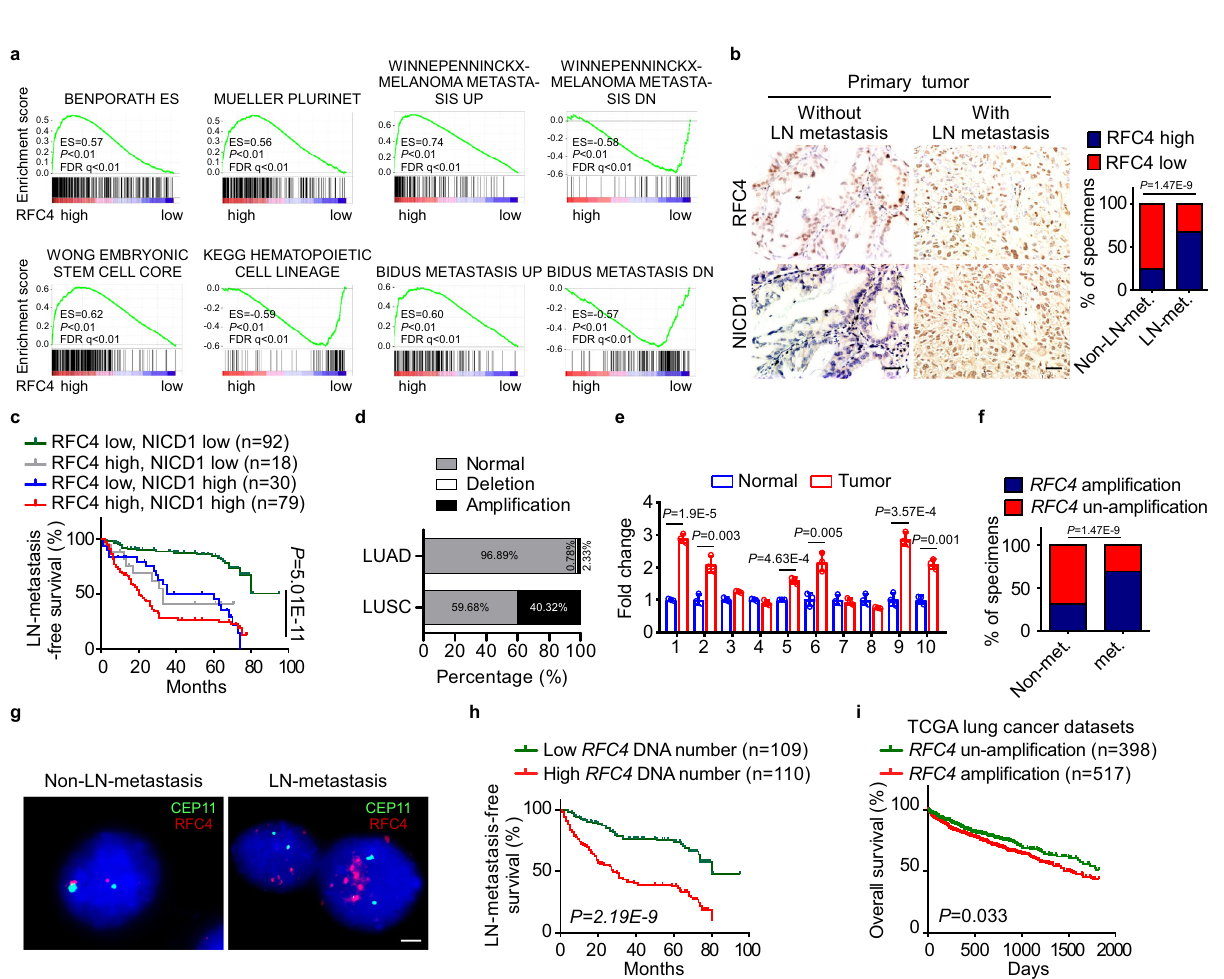
Fig. 7 RFC4 is ampli fi ed in NSCLC and correlates with NSCLC progression. a GSEA analysis of the TCGA lung cancer datasets by Kolmogorov – Smirnov test shows correlation between RFC4 and tumor metastasis- and stemness-associated signatures. b Images of IHC staining for RFC4 and NICD1 in the same set of consecutive tissue slices of primary tumors from 219 NSCLC patients with or without LN metastasis, and the percentages of specimens expressing low or high RFC4 from these NSCLC patients. Two representative cases are shown. Scale bar: 100 μ m. c Kaplan – Meier analysis of the LN metastasis-free survival of our cohort of 219 NSCLC patients by log-rank test, who were divided into low- or high RFC4 and low- or high-NICD1 expression subgroups. The medians of RFC4 and NICD1 expression were used as the cut-off value. d The percentages of RFC4 genetic alterations in LUAD and LUSC patients from the TCGA lung cancer datasets. e The RFC4 DNA quantities in 10 pairs of NSCLC tissues and adjacent non-cancerous lung tissues. f The percentages of RFC4 genetic alterations with or without metastasis from the TCGA lung cancer datasets, which was analyzed by cross-tabulation with two- tailed Chi-square test. g Images of FISH staining for RFC4 genomic ampli fi cation status in primary tumors from NSCLC patients with or without LN metastasis. Two representative cases are shown. Scale bar: 10 μ m. h Kaplan – Meier analysis of the correlation between RFC4 DNA levels or ampli fi cation status and metastasis-free survival of NSCLC patients from our own cohort by Log-rank test. RFC4 DNA level was used as the cut-off value. i Kaplan – Meier analysis of the correlation between RFC4 ampli fi cation status and overall survival of NSCLC patients from TCGA lung cancer datasets by log-rank test. Data in panel b , e are presented as mean ± SD derived from three independent experiments. Two-way ANOVA multiple comparison analysis was used for statistical analysis. Source data are provided as a Source Data fi le.